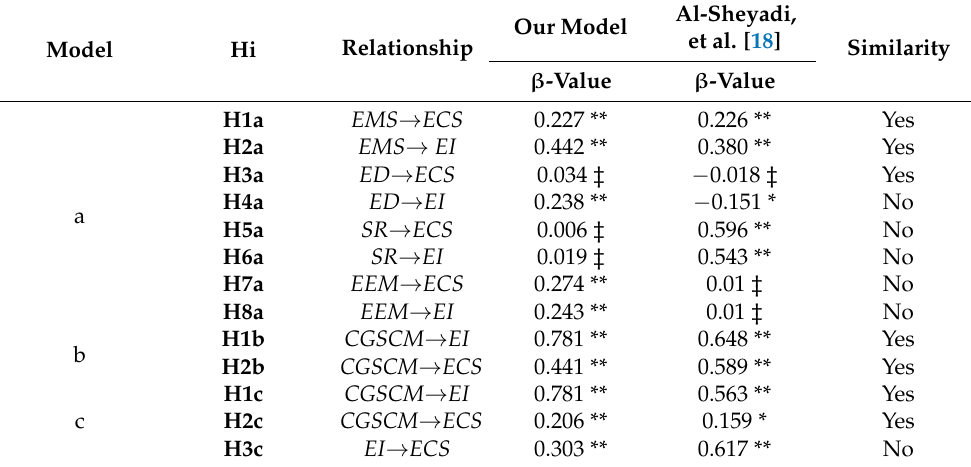
Table 5. Comparison of the direct effects of the first-order model.